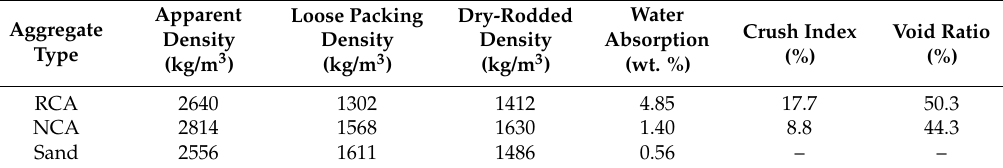
Table 1. Physical properties of the coarse and fine aggregate.